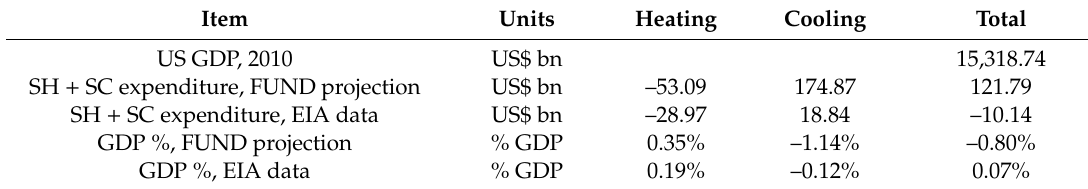
Table 2. Economic impact of 3 ◦ C GMST increase, from 2000, on US space heating and space cooling energy expenditure in residential and commercial buildings. Projections are with non-temperature drivers constant at 2010